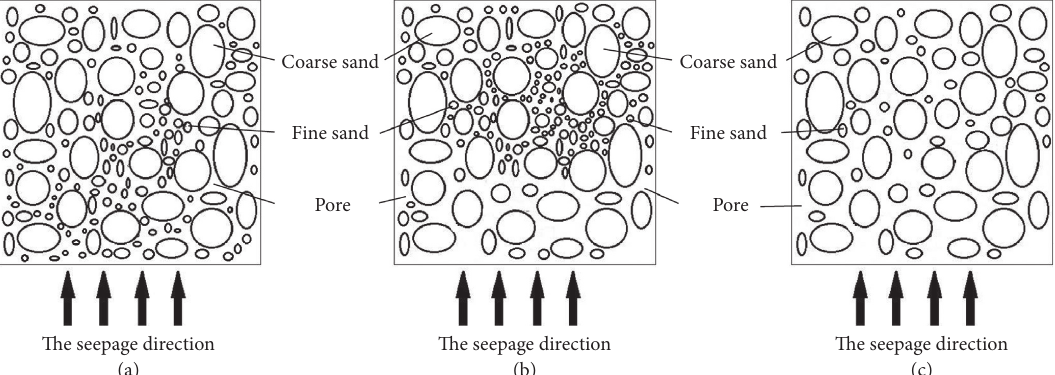
Figure 4: Schematic diagram of different seepage stages. (a) The stable seepage stage. (b) The particle blockage stage. (c) The seepage failure stage.